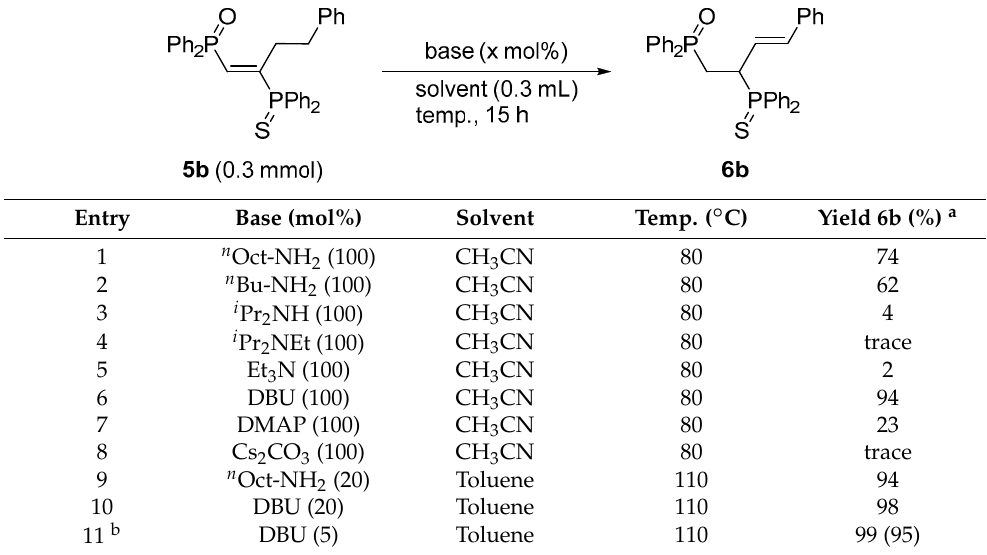
Table 5. Optimization of the reaction conditions for the base-catalyzed double-bond isomerization of 5b .